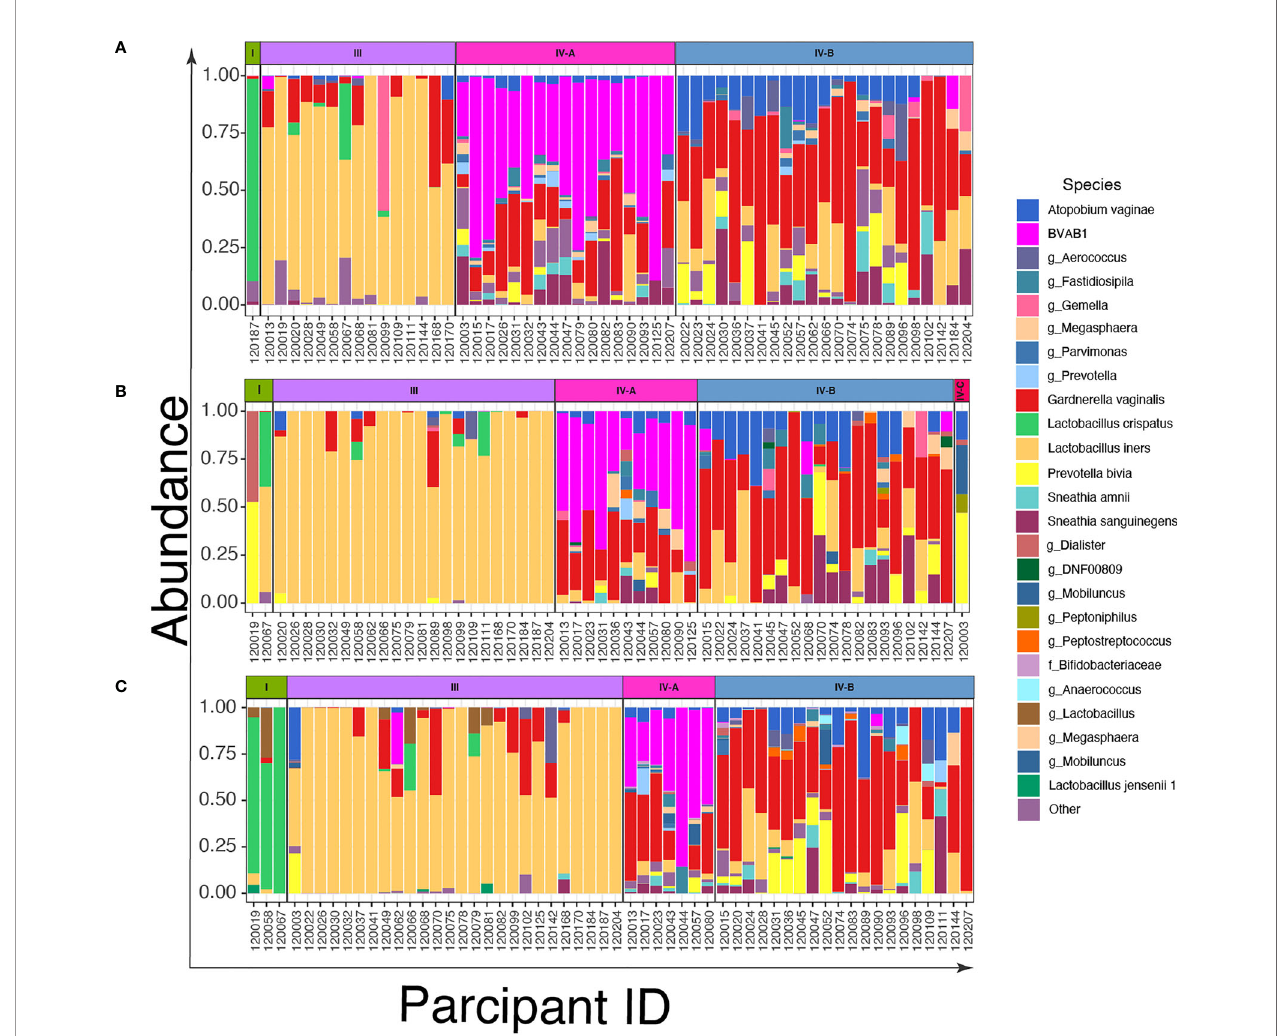
FIGURE 2 | Bar plots of the relative abundance of the twenty most common taxa in cervicovaginal bacterial communities in women (n=56) before and after treatment with metronidazole with and without sexually transmitted infection (STI) treatment (A) at baseline; (B) at 6 weeks post-treatment, and (C) at 12 weeks